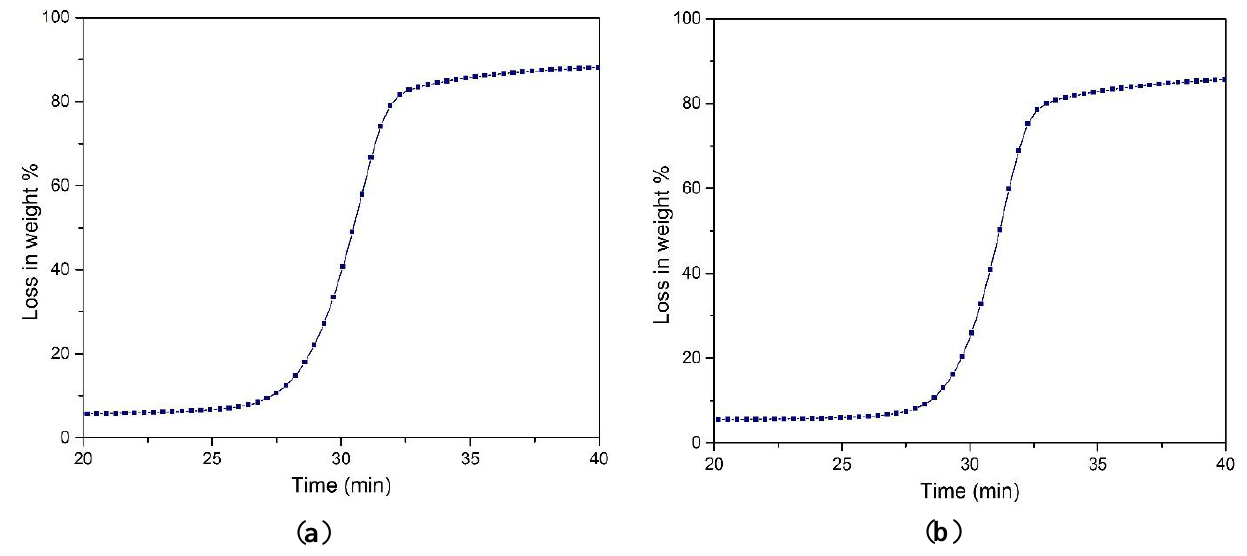
Figure 8. TGA analysis ( a ) the relation between ln(W 0 − W inf. )/(W t − W inf. ) and time for the untreated MCC ( b ) the relation between ln(W 0 − W inf. )/(W t − W inf. ) and time for the treated